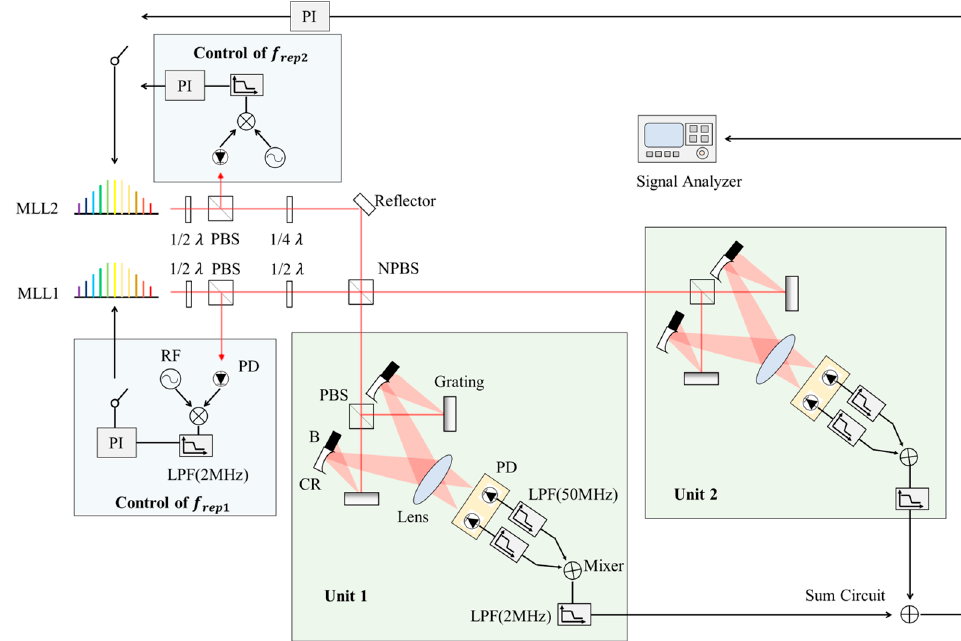
Figure 4. Experimental setup for a timing jitter measurement. 1/2 λ : half-wave plate; 1/4 λ : quarter-wave plate; PBS, polarizing beam splitter; NPBS, nonpolarizing beam splitter; CR, concave reflector; B, blocking board; PD, photodiode; RF, 99 MHz radio frequency source; LPF, low pass filter, 50 MHz LPF is Mini-circuits PLP-50, and 20 MHz LPF is Mini-circuits SLP-1.9+; Mixer, MDP-1+; PI, proportional integral circuits.